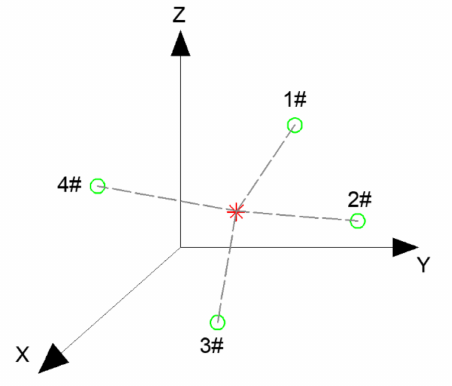
Figure 6. Schematic diagram of time difference